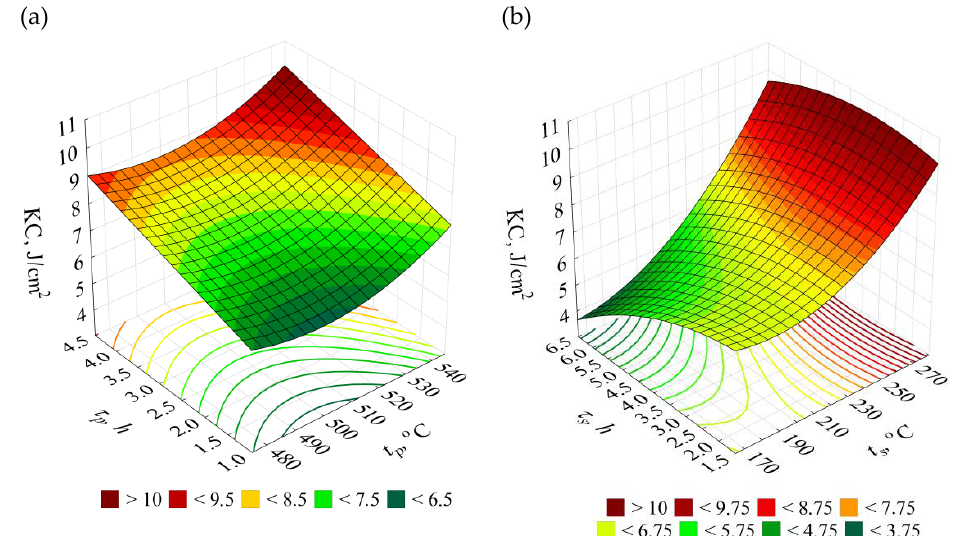
Figure 11. Effects of the T6 heat treatment parameters on impact strength KC of the EN AC–AlSi11(Fe) alloy for determined ( a ) t s = 280 °C, τ s = 5 h, ( b ) t p = 545 °C, τ p = 2.5 h.